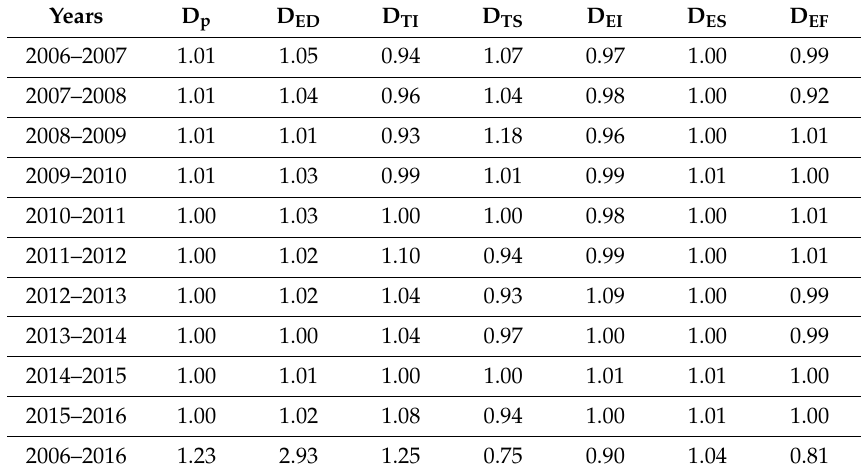
Table 2. The contribution rate of seven factors to the growth of CO 2 emission of the Pearl River Delta. Years D